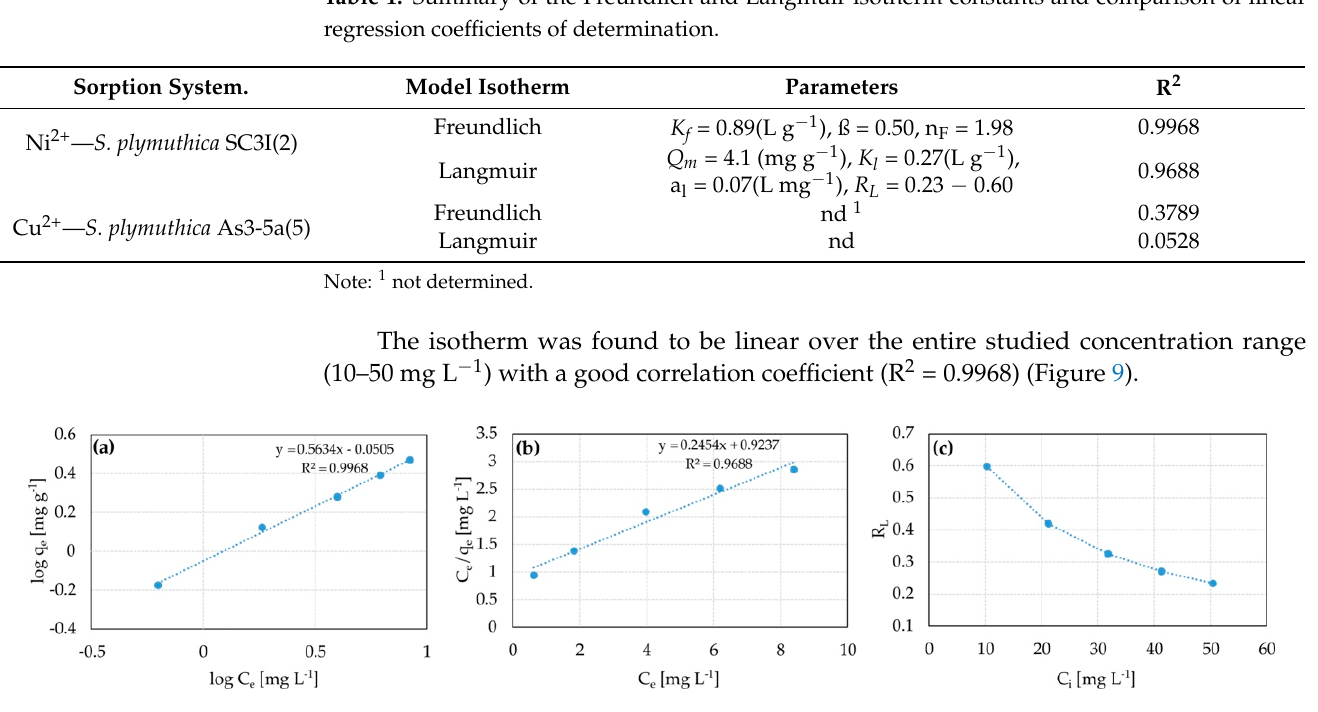
Figure 9. Adsorption isotherms for Ni 2+ by S . plymuthica strain SC3I(2): Freundlich isotherm (a) , Langmuir isotherm (b), and Langmuir separation factor (c) (amount of biomass, 2.73 × 10 10 cell mL − 1 ; initial Ni 2+ concentration, 50 mg L − 1 ; temperature, 24 °C; agitation rate, 100 rpm; contact time, 30